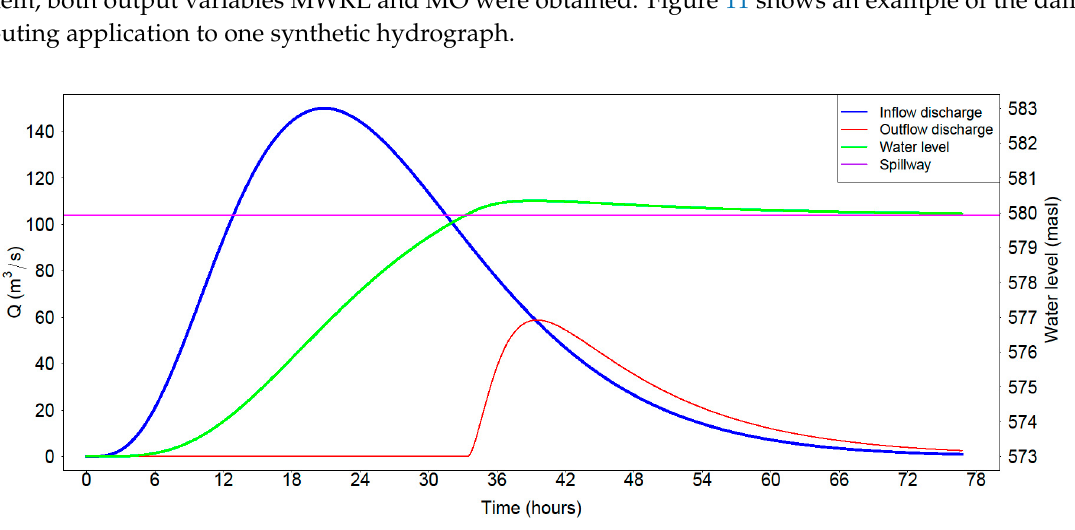
Figure 11. Illustrative example of dam routing applied to one synthetic hydrograph.